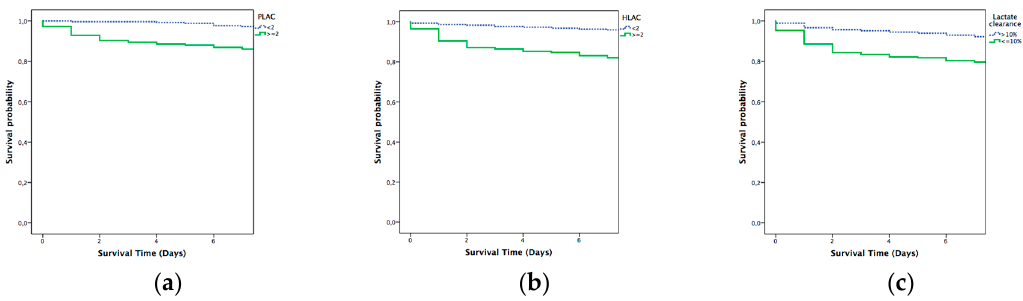
Figure 4. Kaplan–Meier analysis for 7 day mortality: ( a ) prehospital lactate; ( b ) hospital lactate; and ( c ) lactate clearance. PLAC: prehospital lactate; HLAC: hospital lactate.